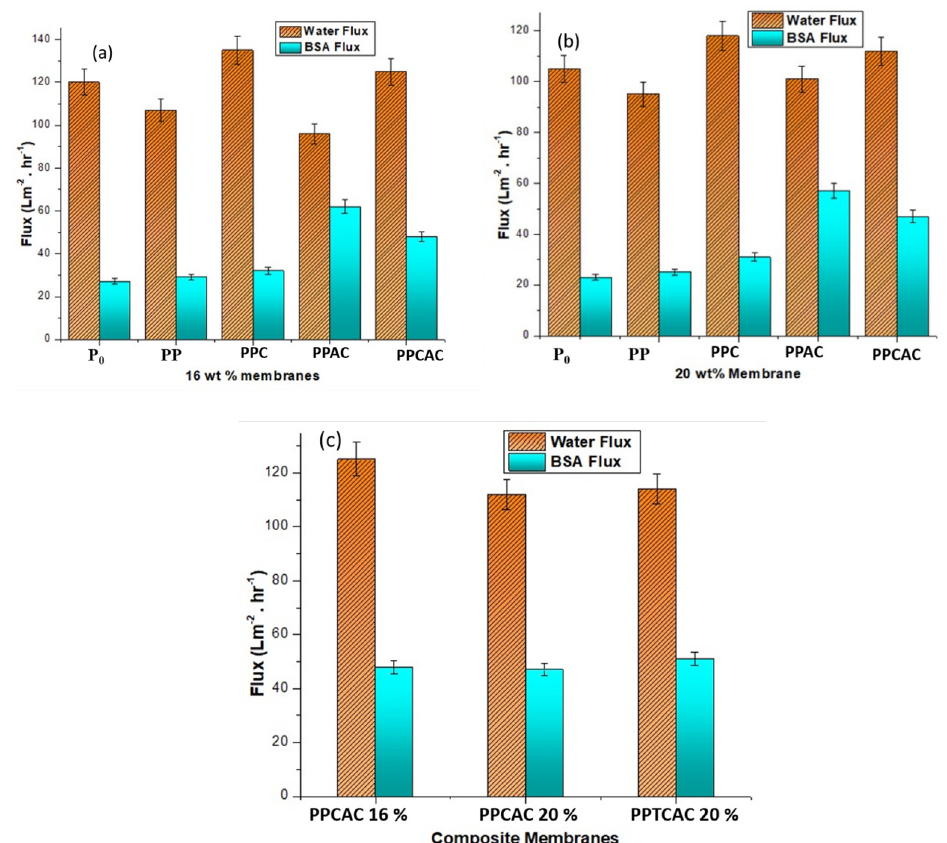
Figure 11. Water flux and BSA flux results for ( a ) 16% wt. membranes, ( b ) 20% wt. membranes and ( c ) composite membranes.